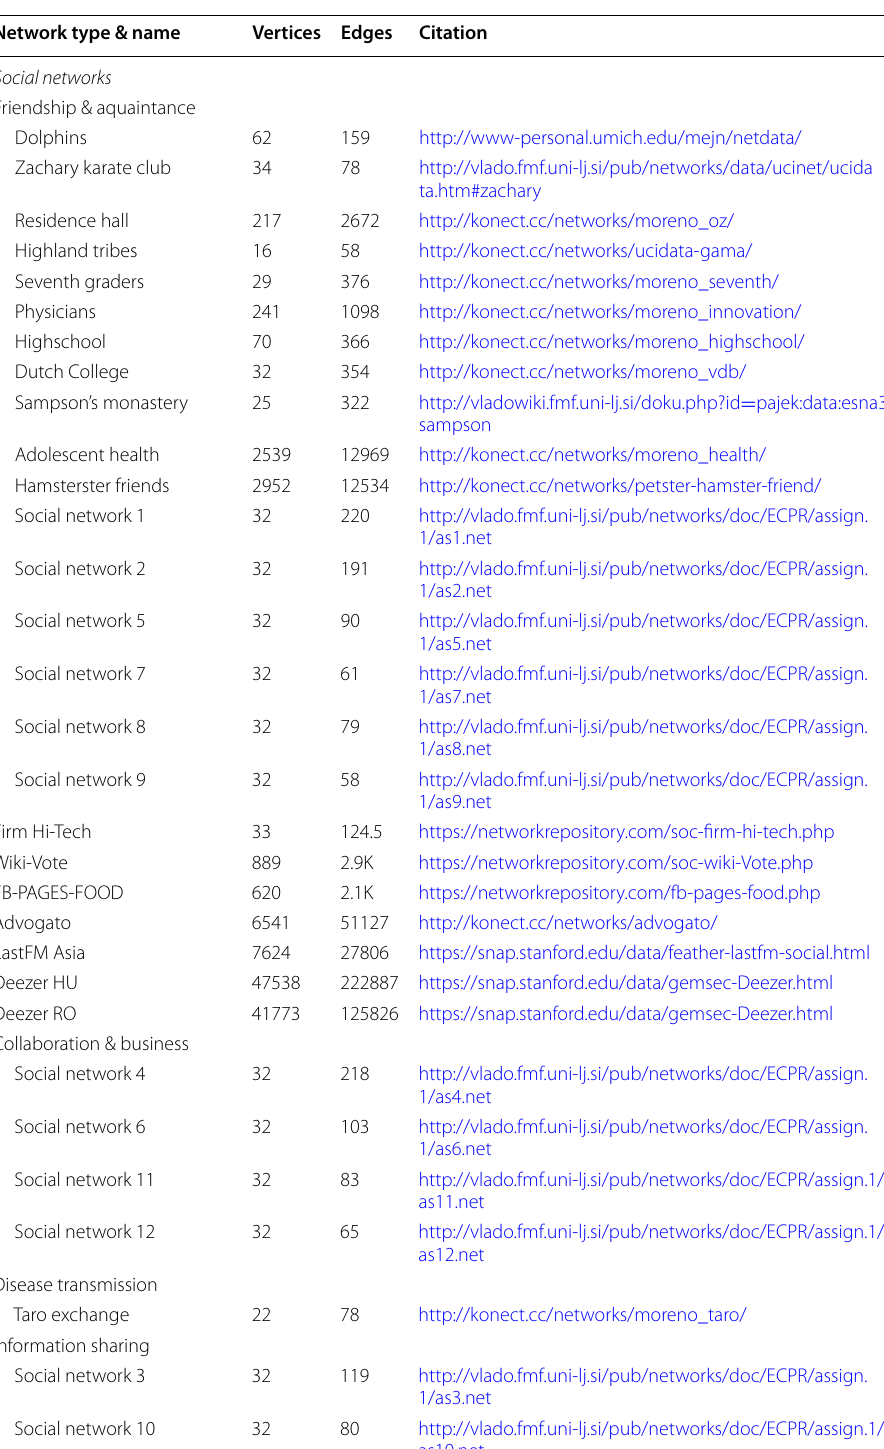
Table 2 Social and genealogical network data sets Network